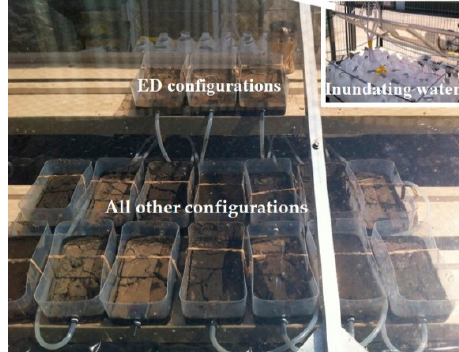
Figure 1. Outdoor experimental set up for the bank sediment survival study, which is covered by a transparent Perspex sheet; ED configurations placed on a higher platform and all the others on the lower platforms. Bottles containing water for inundating sediments (see upper right corner) were located on a vertically moving platform.